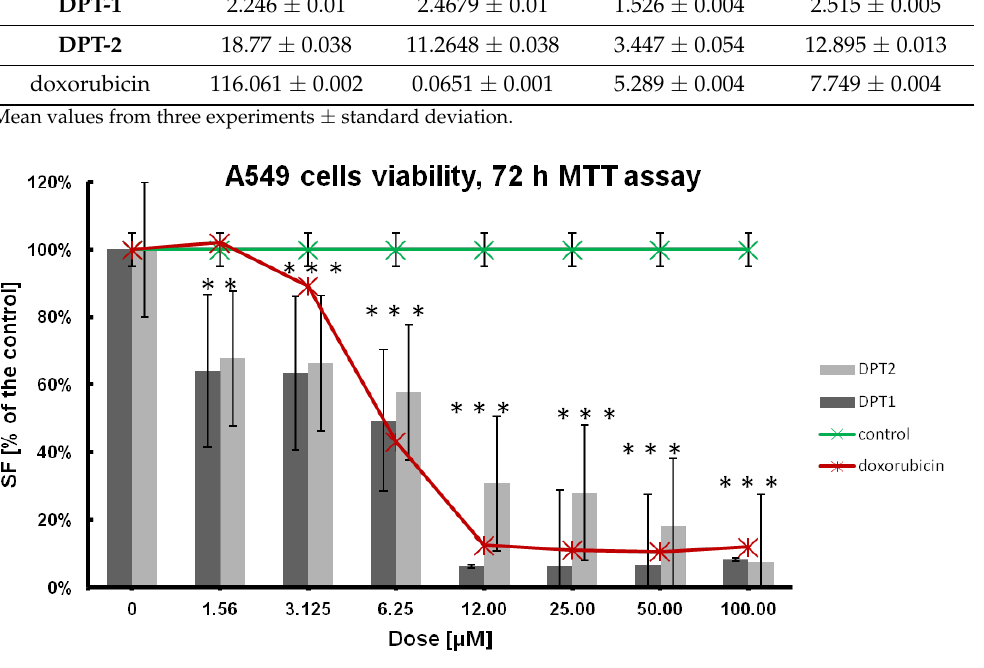
Figure 2. Dose effect of the DPT-1 and DPT-2 treatment on the viability of A549 cells after 72 h of treatment, followed by MTT assay (control—untreated cells; positive control—doxorubicin-treated cells). Data are presented as mean ± SD. *** or **—statistical significance in comparison to the control was calculated with a t -test, and p -value < 0.05 is indicated with a star.